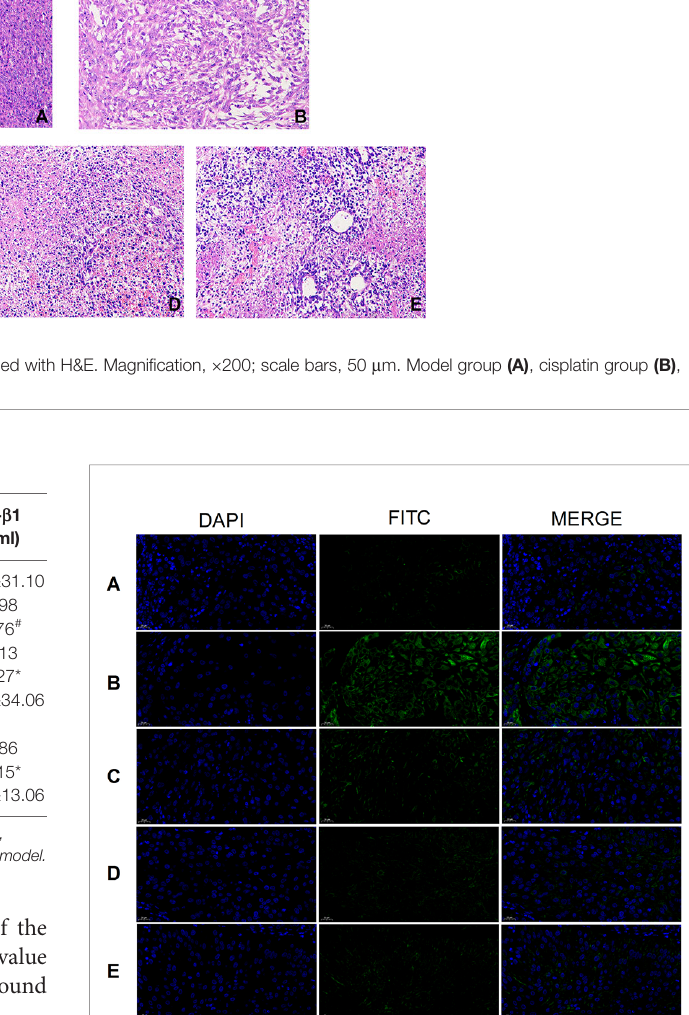
FIGURE 8 | CD44 expression (×400). Model group (A) , cisplatin group (B) , THSWD H group (C) , THSWD M group (D) , THSWD L group (E)